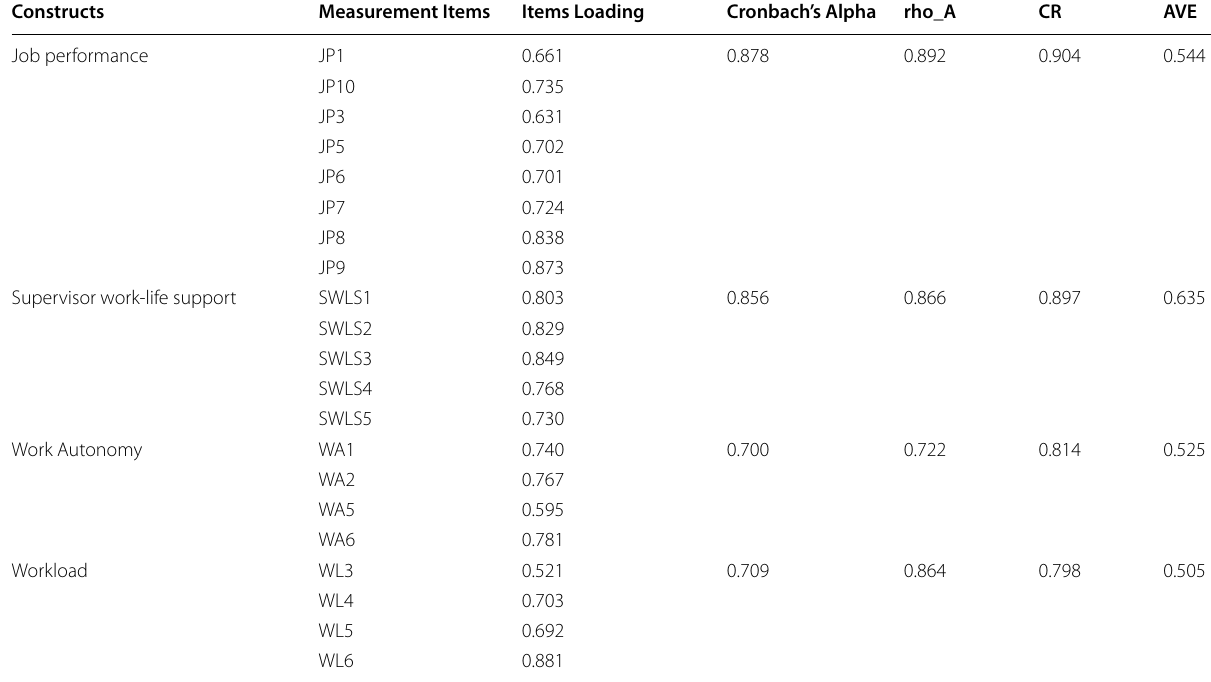
Table 1 Item loading, constructs’ reliability, and validity